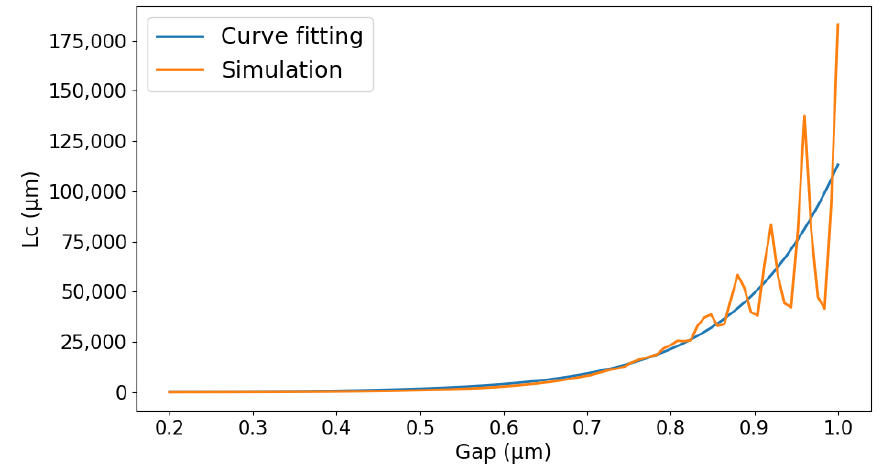
Figure 5. The relation between the DC gap and coupling length L c.